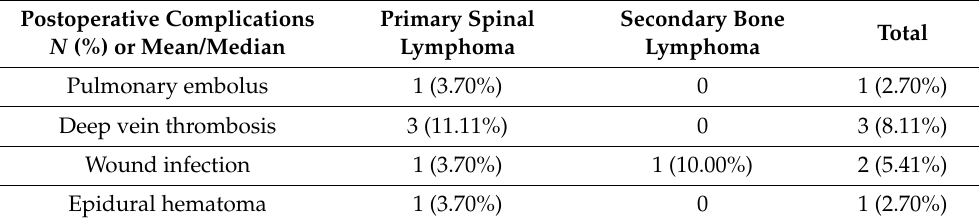
Table 3. Presentation of postoperative